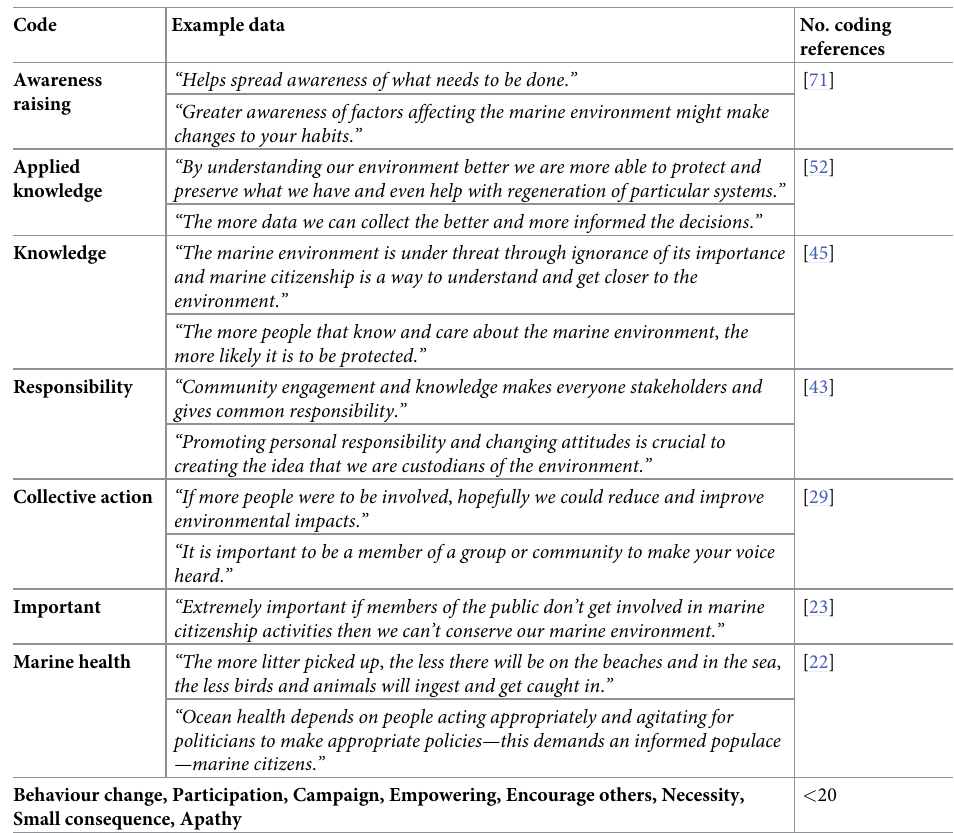
Table 4. Role of marine citizenship in marine environmental health. Responses given by active marine citizens to the question “In what ways do you think marine citizenship is important for marine environmental health?” Responses were coded to draw out key themes. (N = 249). NB. Within Responsibility is included sub codes of Universalism value, Caring and Ownership which were all connected with an expression of being universally responsible for marine